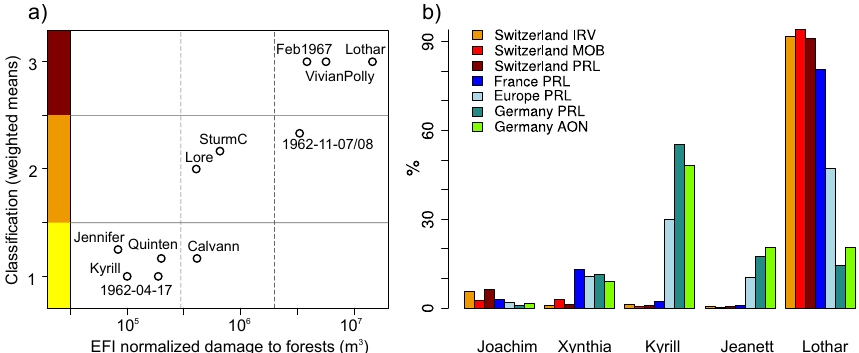
Figure 5. (a) Weighted means of the CAT-DAM classification with regard to normalized (year-of-2010 levels) damage to Swiss forests for 11 windstorms since 1962 (circles; see Sect. 5.1.2 for details) from the European Forest Institute EFI (Gardiner et al., 2010). Filled boxes as in Fig. 1. Grey dotted lines visualize an ideal grouping. (b) Relative losses (%) from five hazardous windstorms (see Sect. 5.1.4) since 1999 in different countries of Central Europe and over the continent with regard to the total losses from the five windstorms. The bars of each color add up to 100%. Abbreviations of sources are as in Fig. 3; in addition, the following two abbreviations are used: PRL – Perils AG; AON – Benfield (see text for